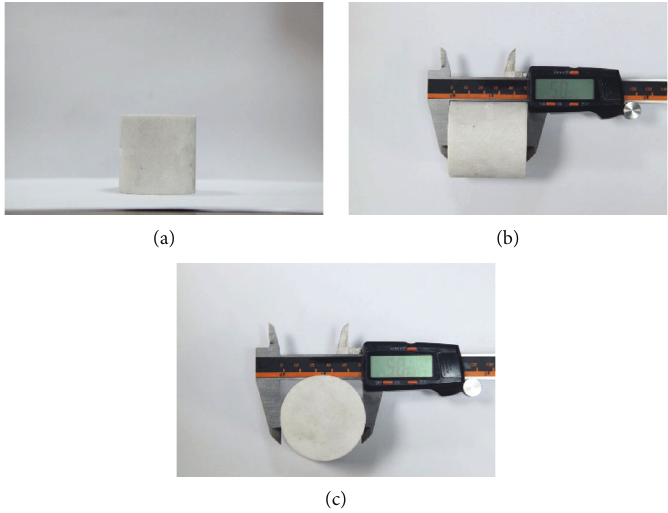
Figure 1: The measurement of sample size. (a) Sample, (b) height, (c)